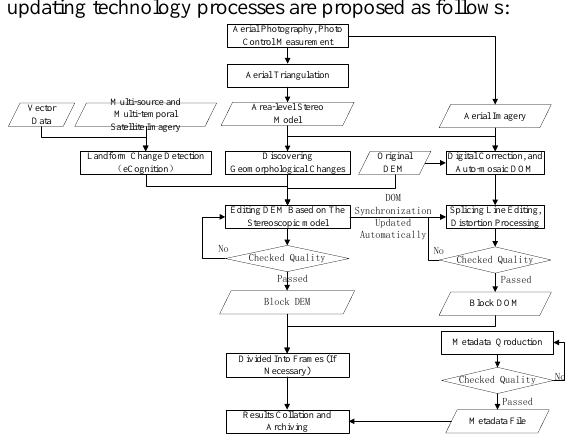
Figure 4. DOM and DEM Rapid Updating Technology Process